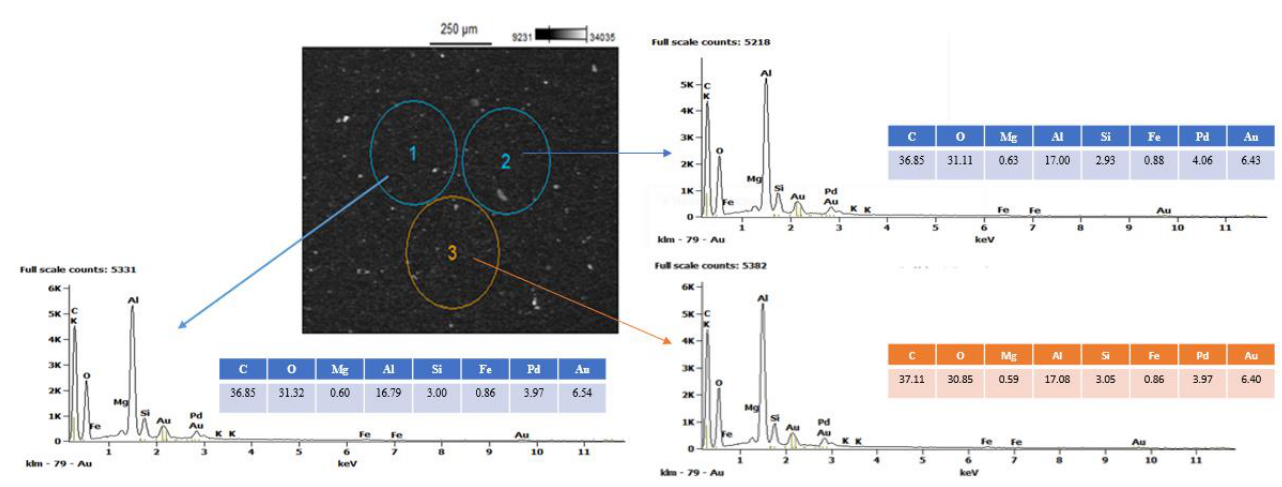
Figure 3. Microanalysis SEM/EDS along with the area EDS spectra (at three different locations (2:1) HNTs and ATH-sil.